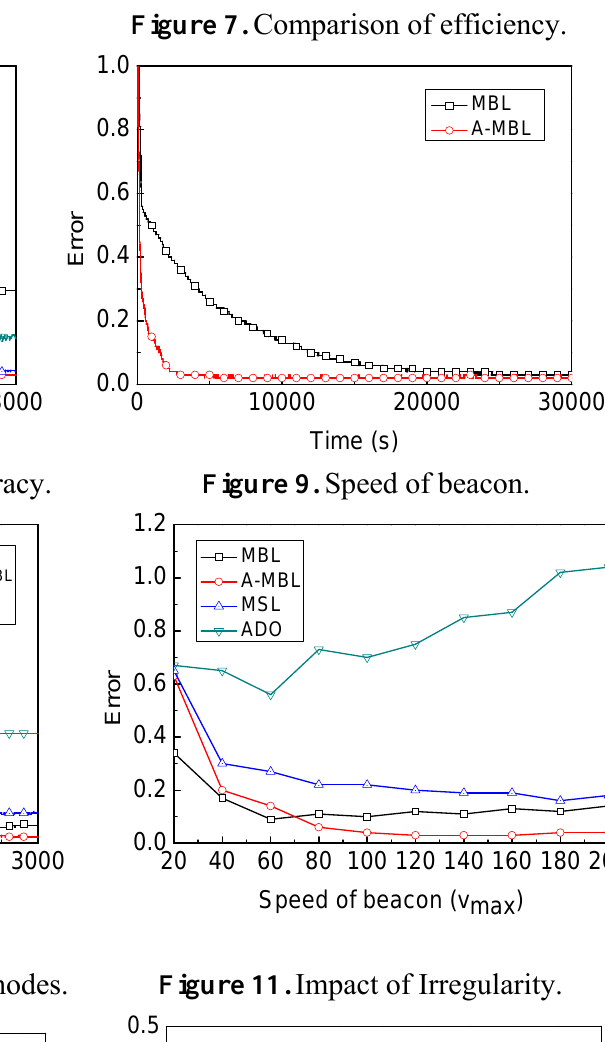
Figure 6. Impact of parameter α . Figure 7. Comparison of efficiency.